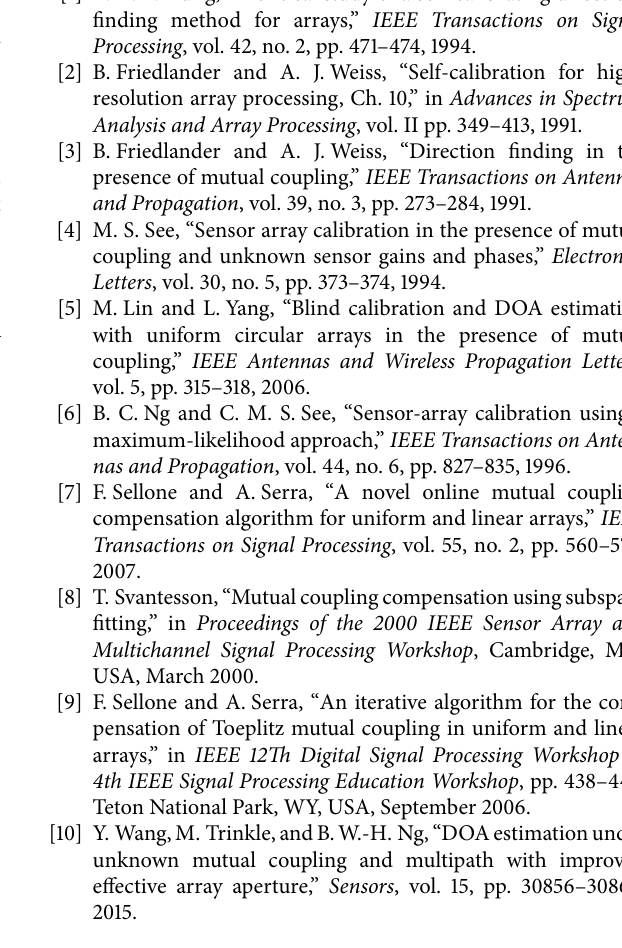
Figure 11: The error in estimating D as function of the number of periods P , for different numbers of signals, when D is constrained to be a banded matrix. All parameters are the same as in Figure